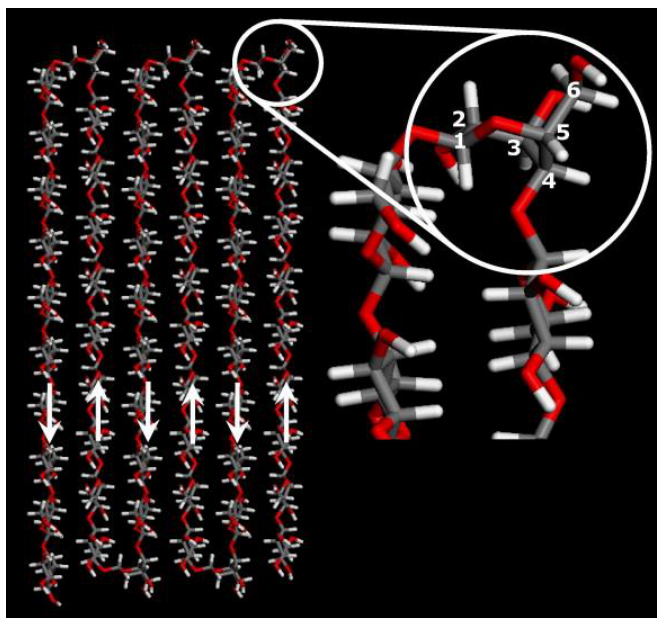
Figure 15. The folded-chain structure linked by the boat ring conformer to allow the “hairpin” turn (magnification inset). The white arrows show the anti-parallel orientation of the cellulose chains, grey–carbon atoms, red–oxygen atoms, white–hydrogen atoms, numbers 1–6 refer to the conventional numeration of carbon atoms of the anhydroglucose unit (AGU);reprinted from [108], with permission from Elsevier, 2013.